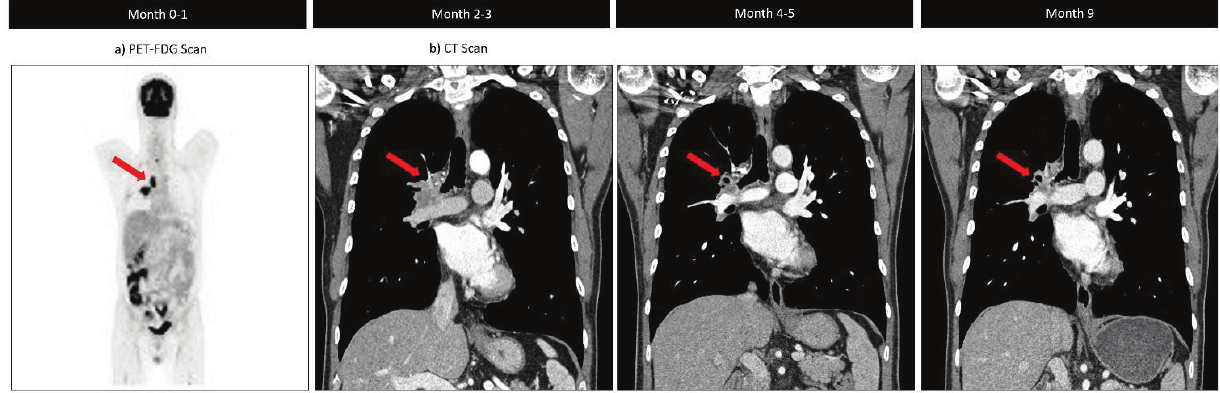
Figure 3. Positron emission and computed tomography showing primary epidermal growth factor receptor + non-small cell lung carcinoma. Osimertinib initiated after two to three month time